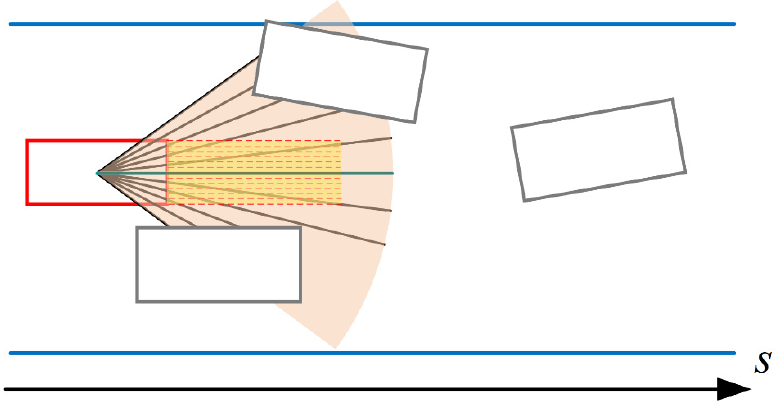
Figure 10. Schematic diagram of self-vehicle obstacle avoidance state input.